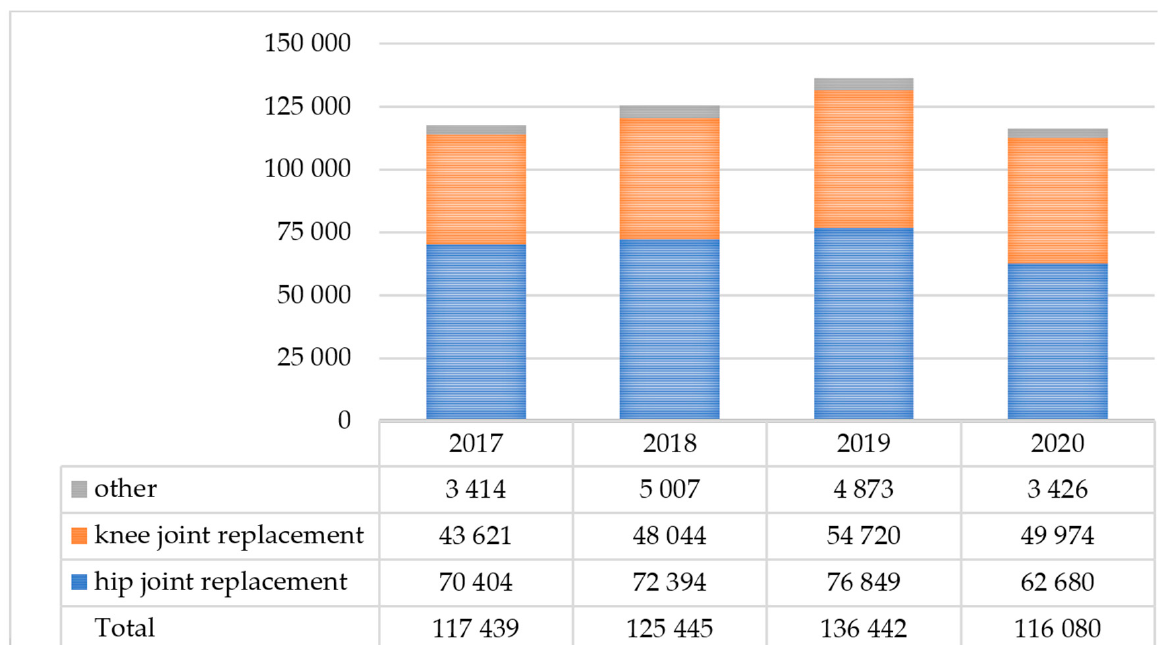
Figure 1. Number of joint replacement surgeries in adult patients performed in 2017–2020 in the Moscow region in the Russian Federation.